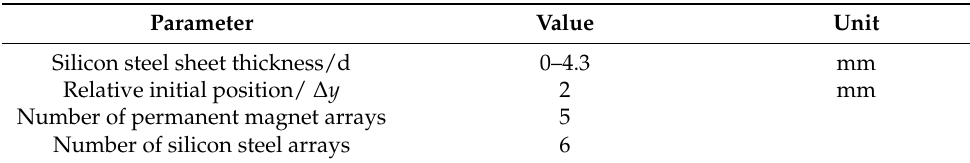
Figure 7. Graph of electromagnetic drive force. Table 3. Parameters of the array.